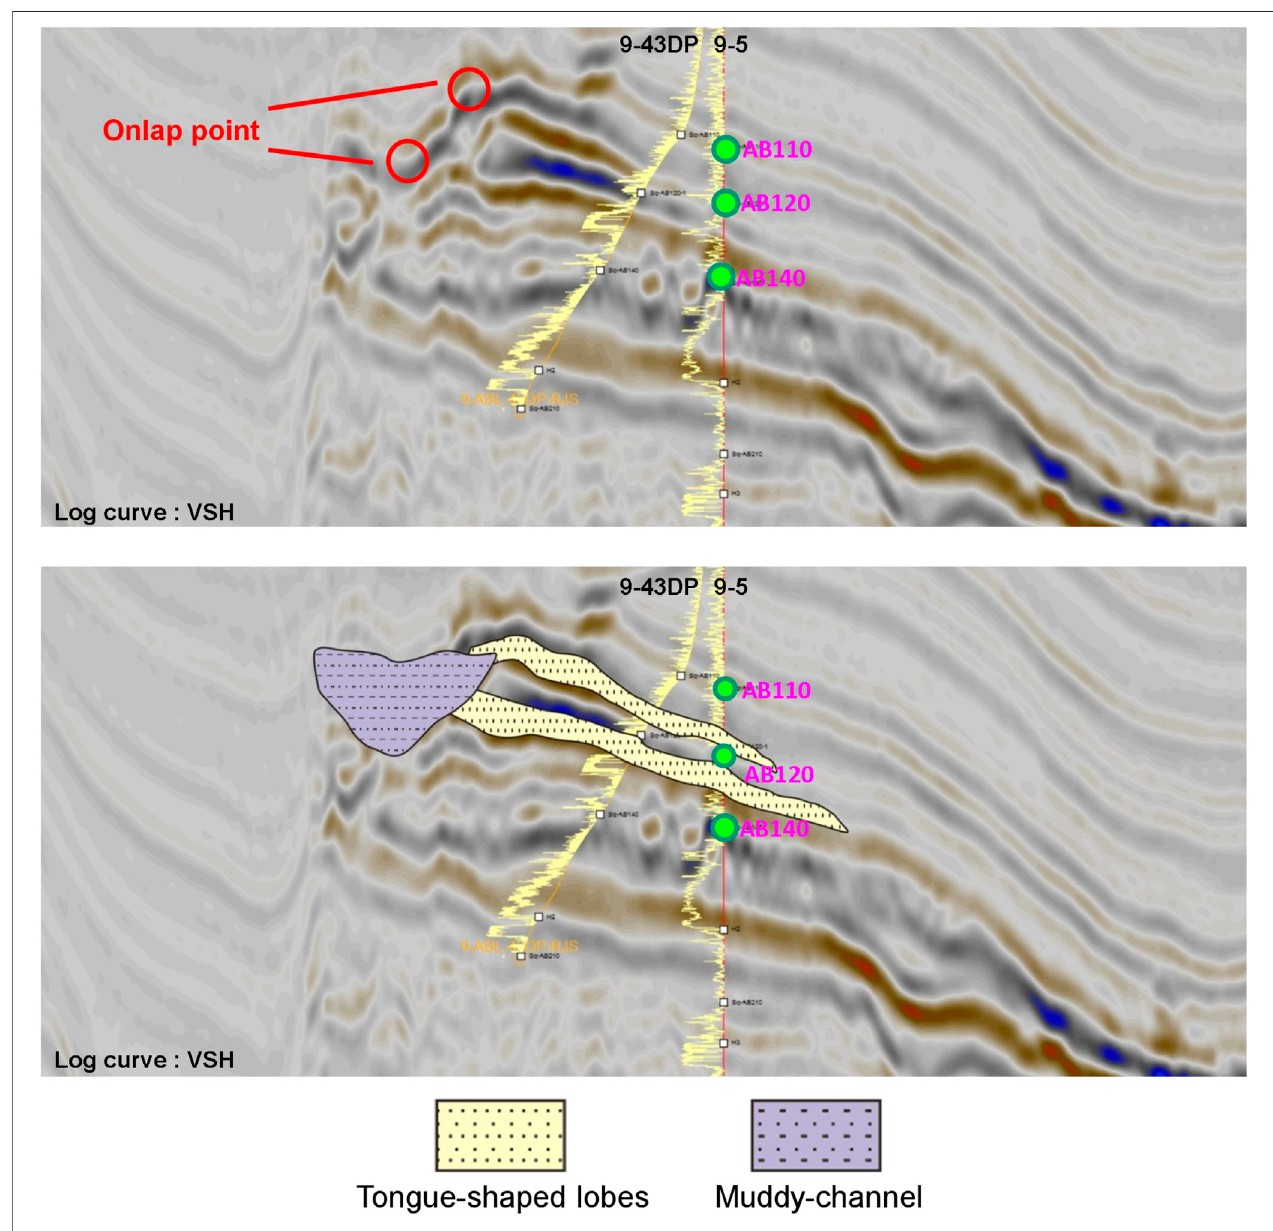
FIGURE 7 | Well seismic pro fi le in the direction perpendicular to material source supply from AB110 to AB120 reservoir — near source end.